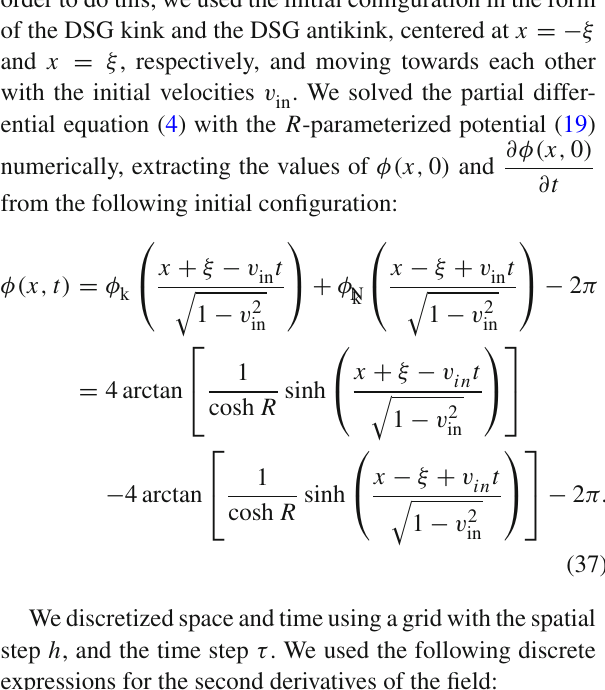
increasing R the frequency ω decreases to zero. At large R ’s 1 and ω are the result of splitting of the zero mode the levels ω 0 1 of each of the two potential wells